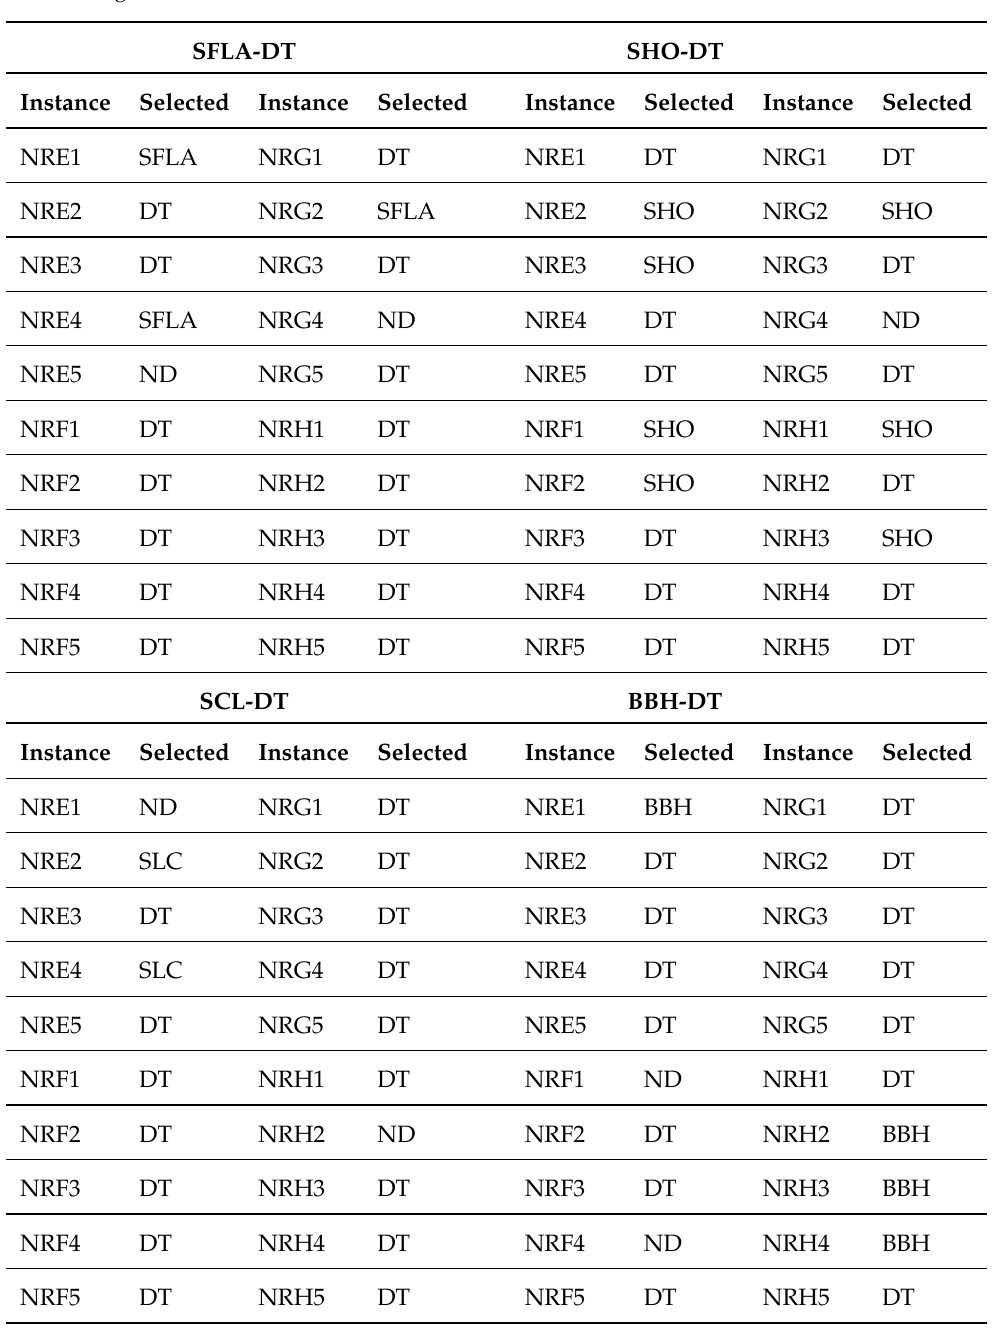
Table 6. Algorithm selected for tested